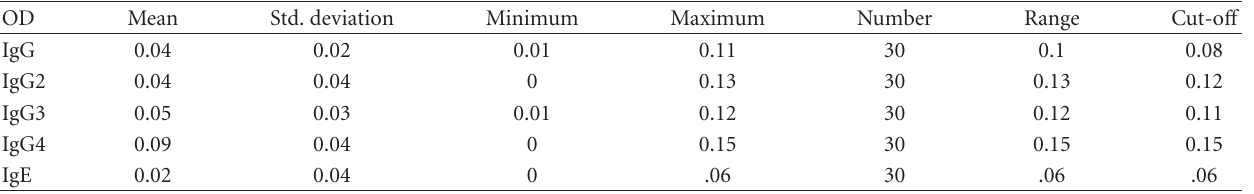
Table 2: The The mean OD values of IgG class and subclass responses of 30 healthy individuals against human cystic crude fluid antigens. OD Mean Std.